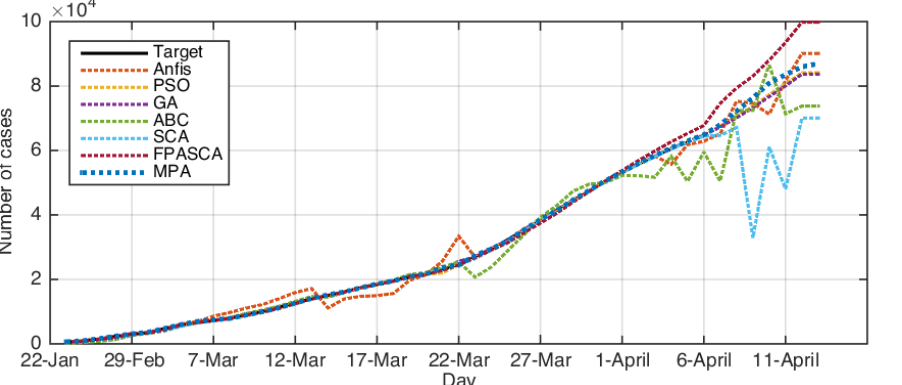
Figure 4. The results for Iran using ABC, ANFIS, FPASSA, GA, MPA, SCA, and PSO against real data (target).